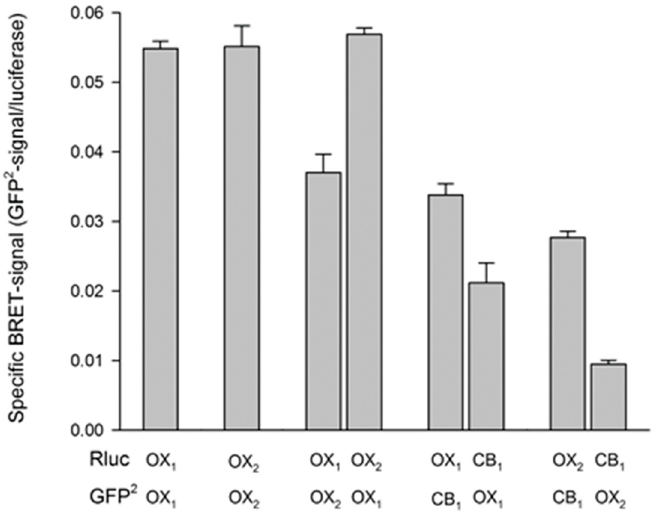
Figure 4. Human orexin and cannabinoid receptor interactions as measured utilizing BRET (BRET 2 ) between renilla luciferase (Rluc) and GFP 2 fused to the receptors’ C-termini. The Rluc background has been subtracted from the values. The data presented are the mean ± SE; n refers to the number of cell batches. Each experiment was performed at least three times in 4–6 replicates. The data originate from Jantti et al. [69].